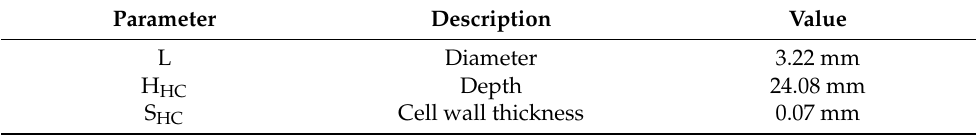
Table 2. Honeycomb cell geometrical parameters.